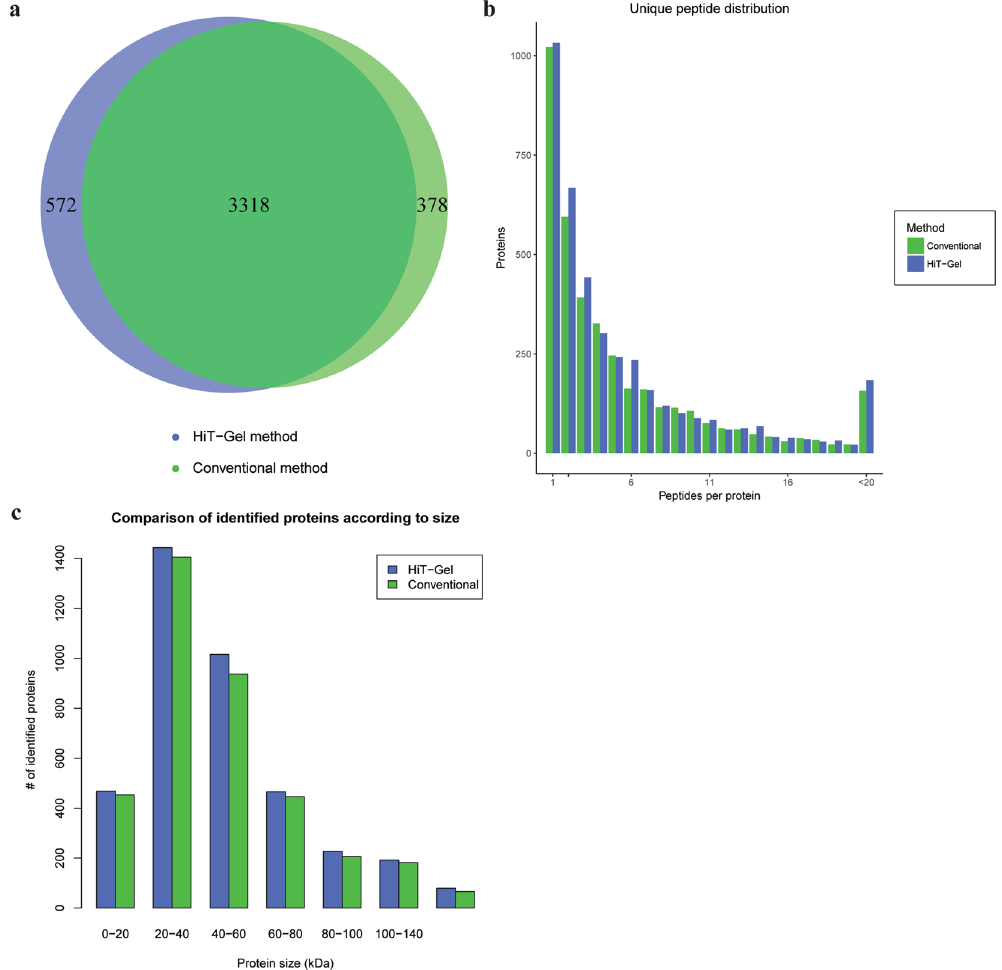
Figure 2. Benchmarking the performance of the HiT-Gel method against the conventional method. ( a ) The overlap between the proteins quantified in each of the methods is presented as a Venn diagram. (b) The ability of each method to measure unique peptides per protein on average was calculated. To visually represent the data, a bar plot was produced that shows the difference between the average number of unique peptides per protein for the HiT-Gel method and the conventional method. (c) The ability of each method to quantify proteins across the size range of 0 to 600 kDa is represented as a